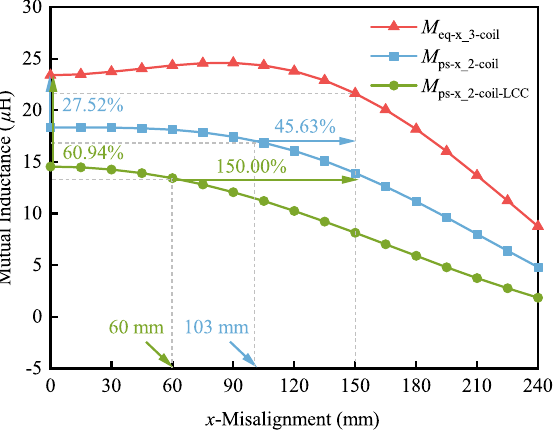
Figure 6. Comparison between M eq − 3 − coil , M ps − 2 − coil , and M ps − 2 − coil − LCC versus misalignment under x -misalignment from 0 to 240 mm.